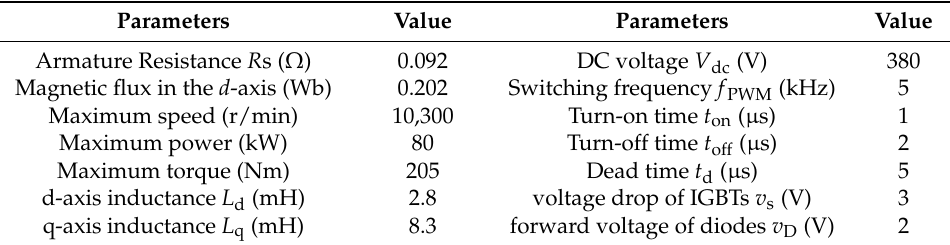
Table 1. Specification of the permanent magnet synchronous motor (PMSM).